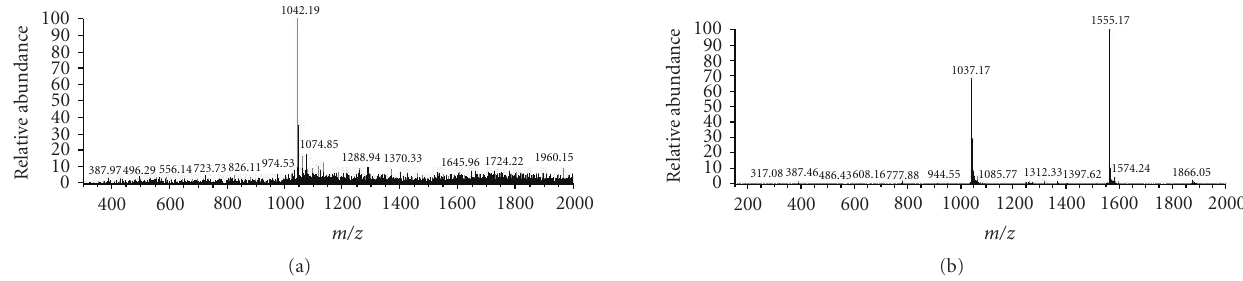
Figure 6: (a) Mass spectrum of the cleaved T α 1. The attachment of 3 protons per peptide molecule leads to only 1 of m/z peak; m/z = 1042.19. (b) Mass spectrum of the synthesized T α 1. The attachment of 2 and 3 protons per peptide molecule leads to 2 peaks of m/z = 1037.80 and 1555.06.